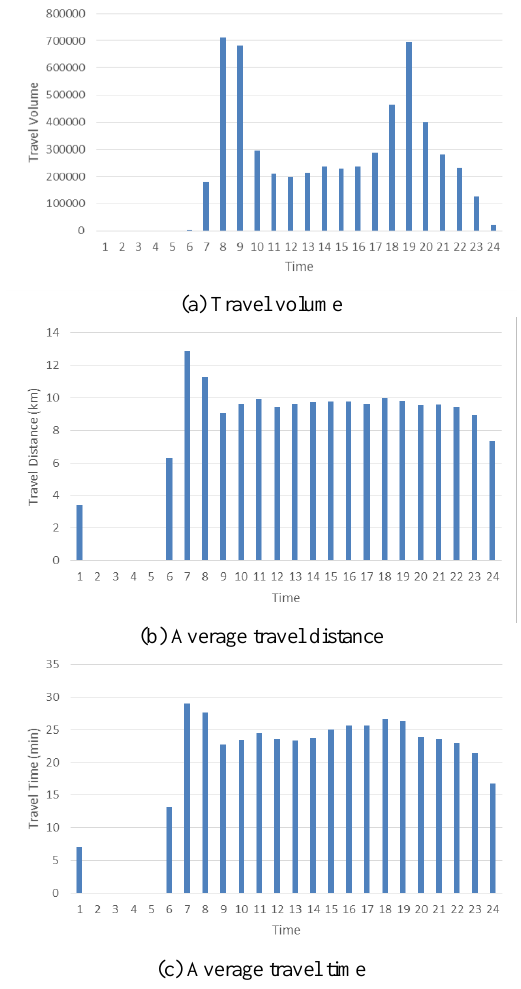
Figure 4. Temporal variation of trips inferred from smart card data